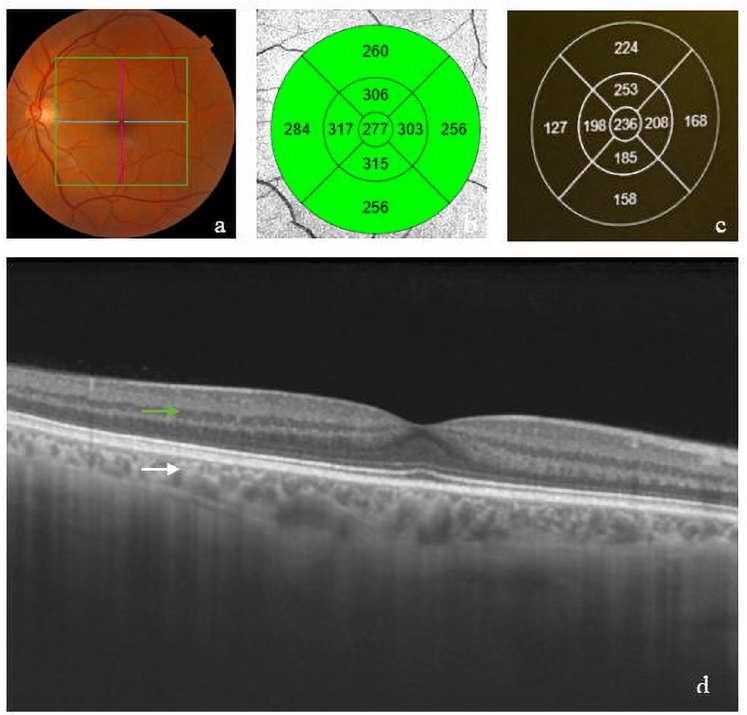
Fig 1. Macular SS-OCT in GD Type I. A.) macular grid in retinography; B.) retinal thickness map; C.) choroidal thickness map; D.) macular SS-OCT [white arrow] and retina [green